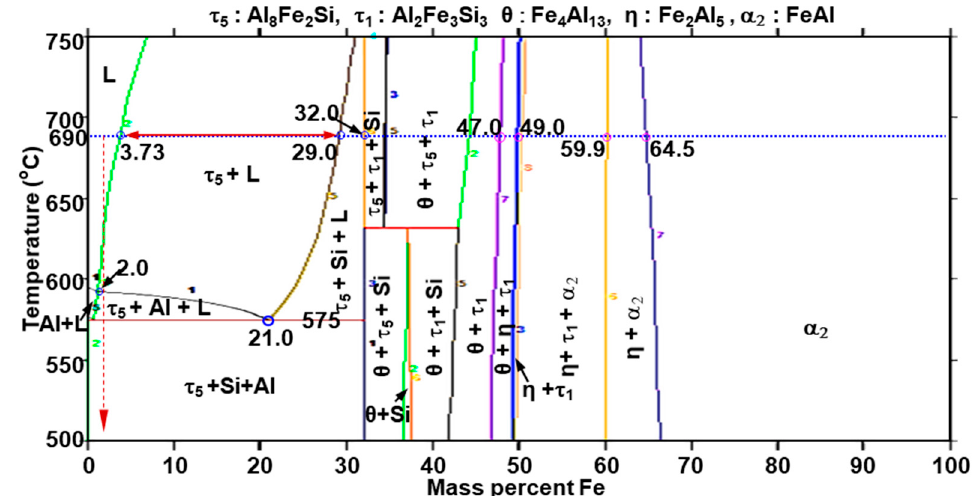
Figure 11. Vertical section (isopleth) of the (Al–Si–Fe) ternary system, calculated with Thermo-Calc Al database version 6.0 (TCAL6). The silicon (Si) is kept constant at 10 wt %. Table 4. Composition and crystal structure of the phases shown at 690 °C in the phase diagram. Phase Crystal Structure